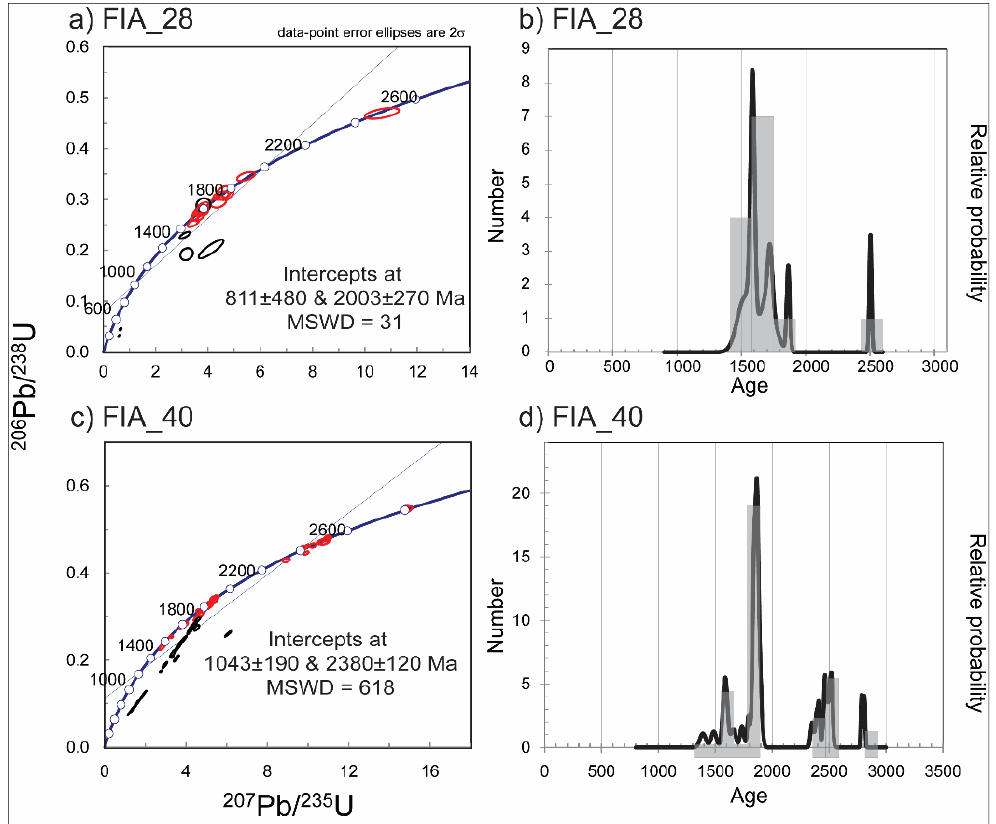
Figure 6. U–Pb concordia plots for basal diamictite samples overlying the Carrapateena deposit. ( a , b ) FIA_28 U-Pb concordia plot and histogram; ( c , d ) FIA_40 U-Pb concordia plot and histogram. Sample locations are shown in Figure 1b.